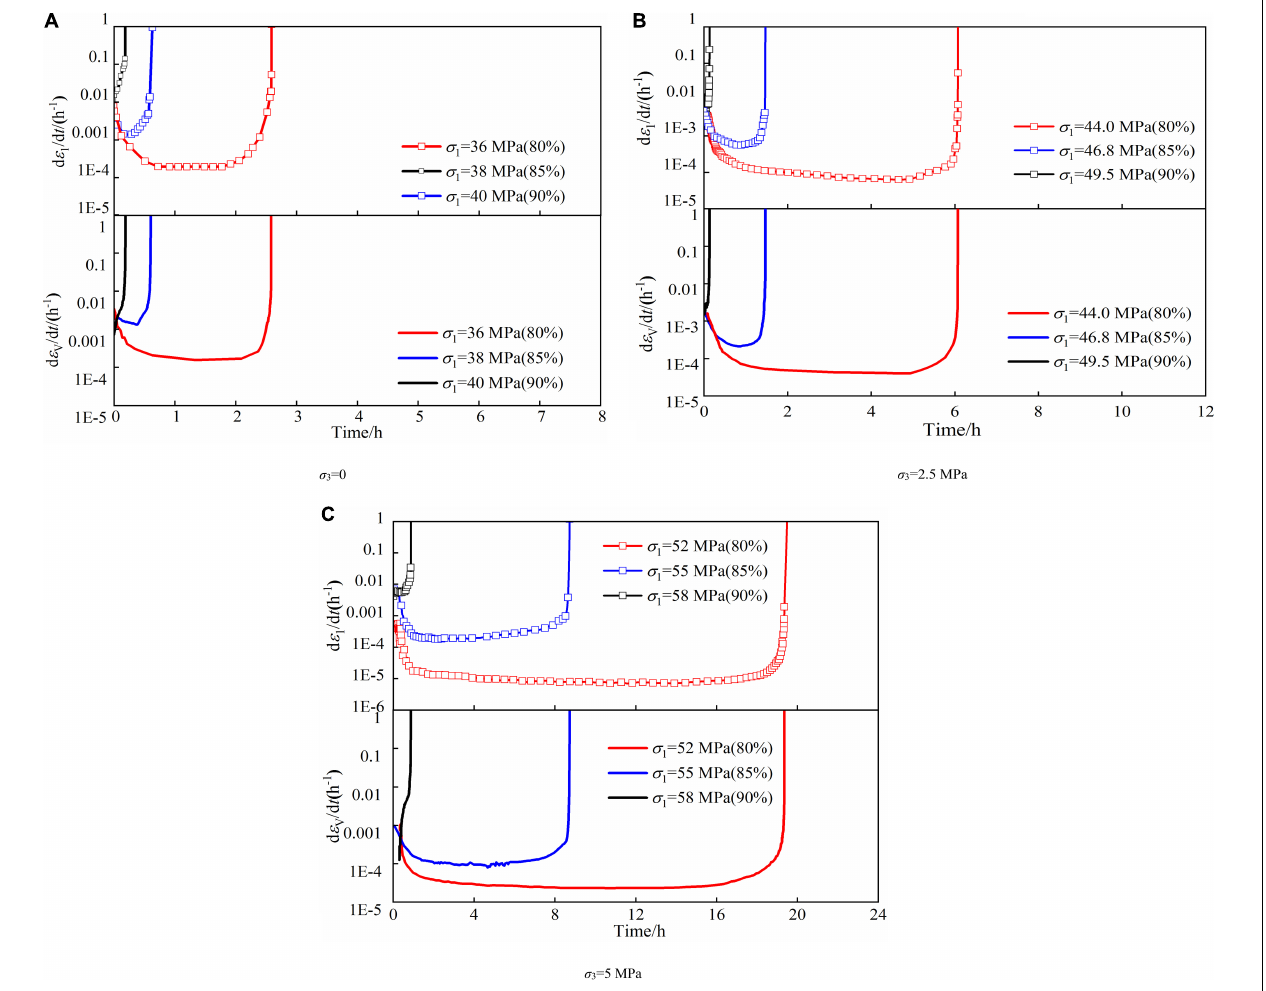
FIGURE 6 | Axial and volumetric strain rates under various confining pressures. (A) σ 3 = 0. (B) σ 3 = 2.5 MPa. (C) σ 3 = 5 MPa.